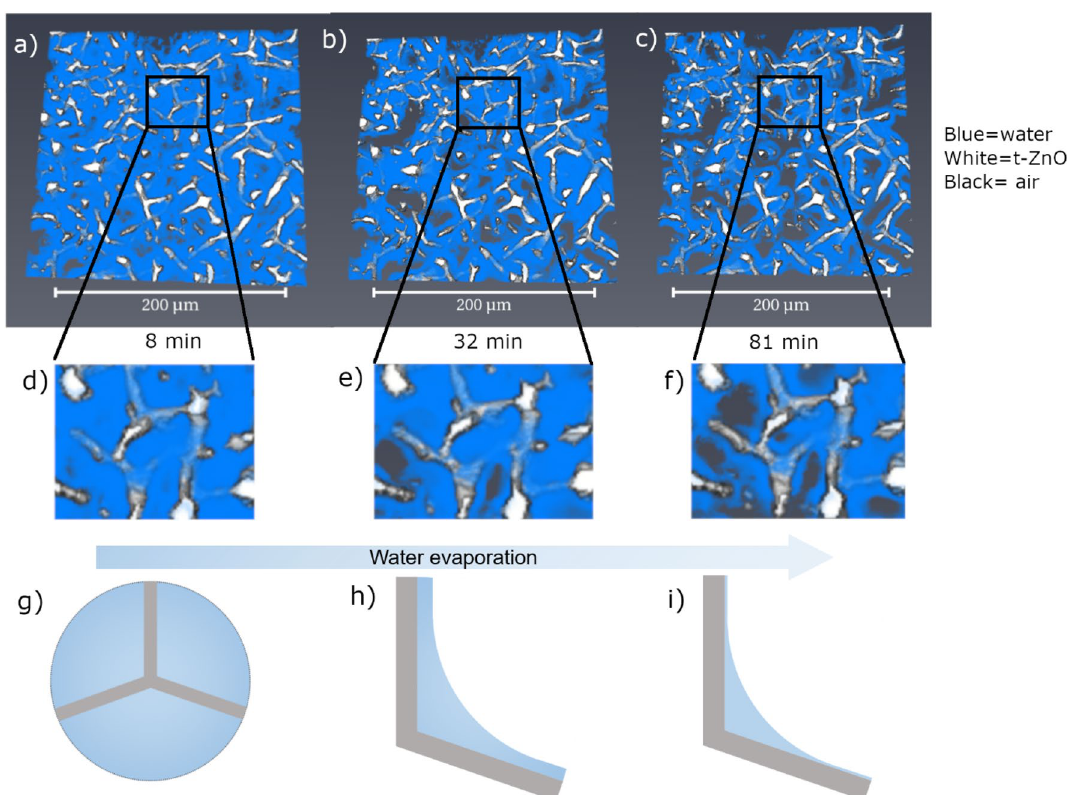
Figure 6. Evaporation process of water of sample 3 in the t-ZnO network ( a – c ). At first ( a ), nearly the whole sample is wetted by the medium, with only very large pores being without the medium. As seen in ( d ) and schematically in ( g ), the tetrapods are completely surrounded by the medium. After some time ( b ) the areas without medium grow so that menisci form around the tetrapod arms. This is shown in ( e ) and